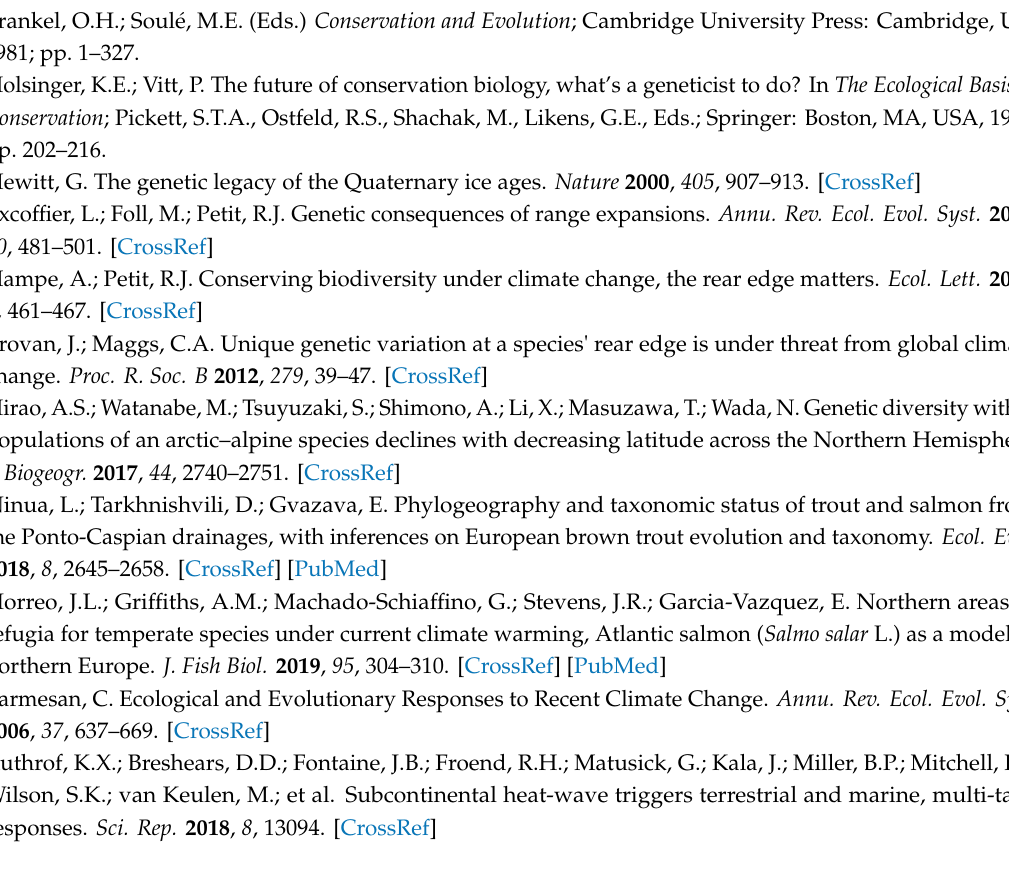
methods for filtering of ddRAD-seq derived SNPs, and description of population structure results obtained with neutral SNP and SSR marker sets. Figure S1: Mantel test for SNP and SSR markers. Figure S2: DAPC scatterplots for axes 2 and 3 for SNP and SSR markers. Figure S3: outputs of snapclust function for SNP and SSR markers. Figure S4: DAPC scatterplots and compoplot for neutral SNP markers. Figure S5: DAPC scatterplots and compoplot for neutral SSR markers. Figure S6: outputs of snapclust function for neutral SNP markers. Figure S7: outputs of snapclust function for neutral SSR markers. Figure S8: proportion of significant nucleotide-BLAST hits of ddRADseq tags to species, phyla, and kingdoms. Table S1: description of the sampling localities, values of environmental parameters within each sampling locality, and pairwise correlation among the di ff erent environmental parameters. Table S2: pairwise comparisons of within-locality H E for SNPs and SSRs. Table S3: correlation of genetic diversity metrics with latitude for SNPs and SSRs. Table S4: pairwise F ST for SNPs and SSRs. Table S5: candidate outlier loci SSR alleles that correlated significantly with environmental